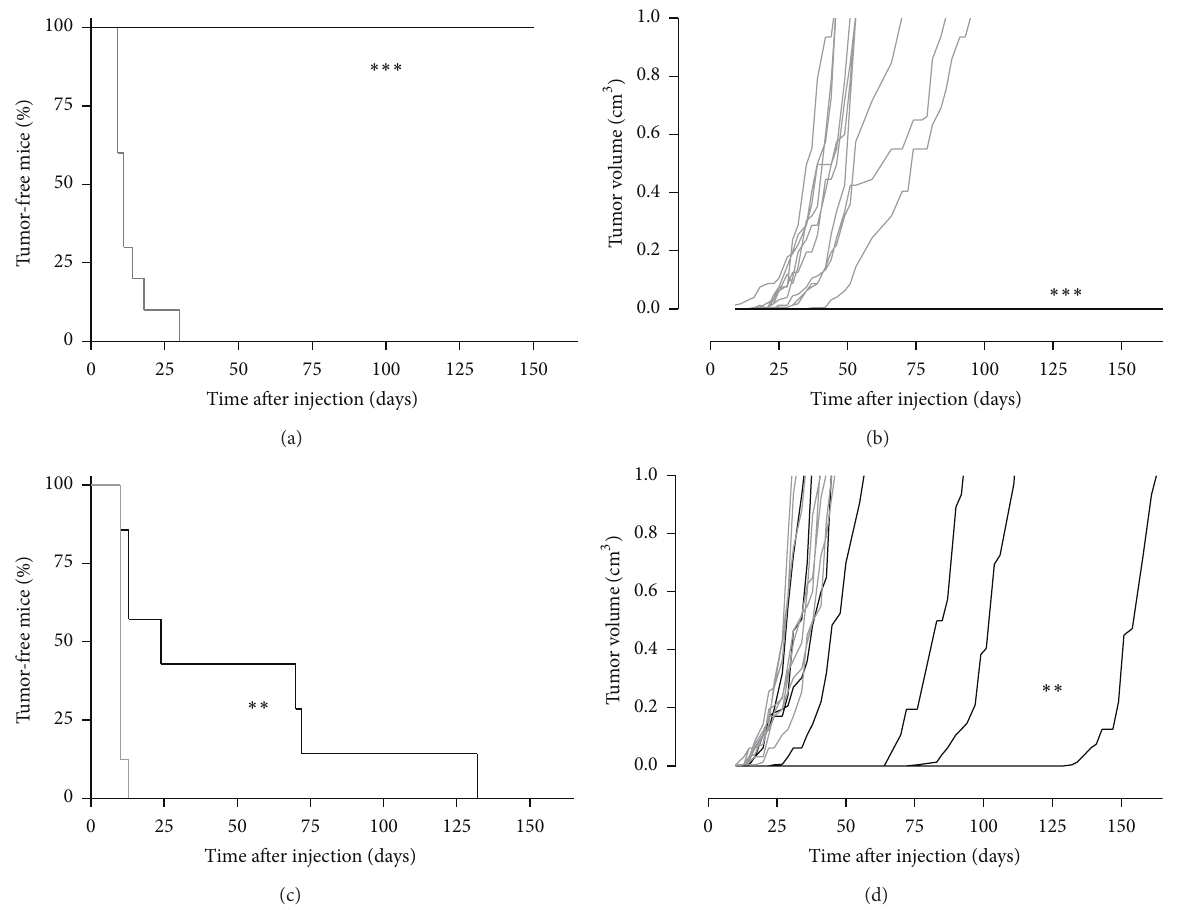
Figure 4: Intradermal EP vaccination protects BALB/c and BALB-neuT mice against a TUBO challenge. Mice were immunized twice with empty (pVAX, gray line) or ECTM (pVAX-ECTM, black line) plasmid. pVAX-ECTM treated BALB/c mice ( 𝑛 = 12 ) display total tumor protection ((a), 𝑝 < 0 , 0001 ), while control group ( 𝑛 = 10 ) develops fast growing tumors within 30 days after challenge ((b), 𝑝 = 0 , 0003 ). Vaccinated BALB-neuT mice ( 𝑛 = 7 ) display a delayed tumor onset ((c), 𝑝 = 0 , 0030 ) and slower tumor growth ( 𝑝 < 0 , 0016 ) with respect to control group ( 𝑛 = 8 ). Each line refers to an individual tumor. Log-rank (Mantel-Cox) test and Student’s 𝑡 -test were used for statistical